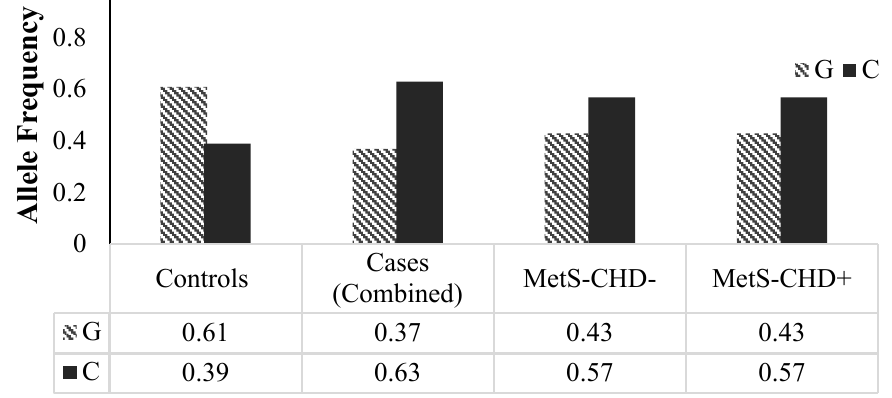
Figure 2. rs1333049 SNP allele frequencies distribution per study groups. The frequencies of the major “G” and minor “C” alleles of rs1333049 SNP in three study groups; healthy controls, cases (combined: MetS and CHD), Mets-CHD − (MetS without CHD) and MetS-CHD + (MetS with CHD) are shown. The minor “C” allele frequency is higher in cases (combined), MetS-CHD − and MetS-CHD + and lower in the control group. MetS, metabolic syndrome; CHD, coronary heart disease.